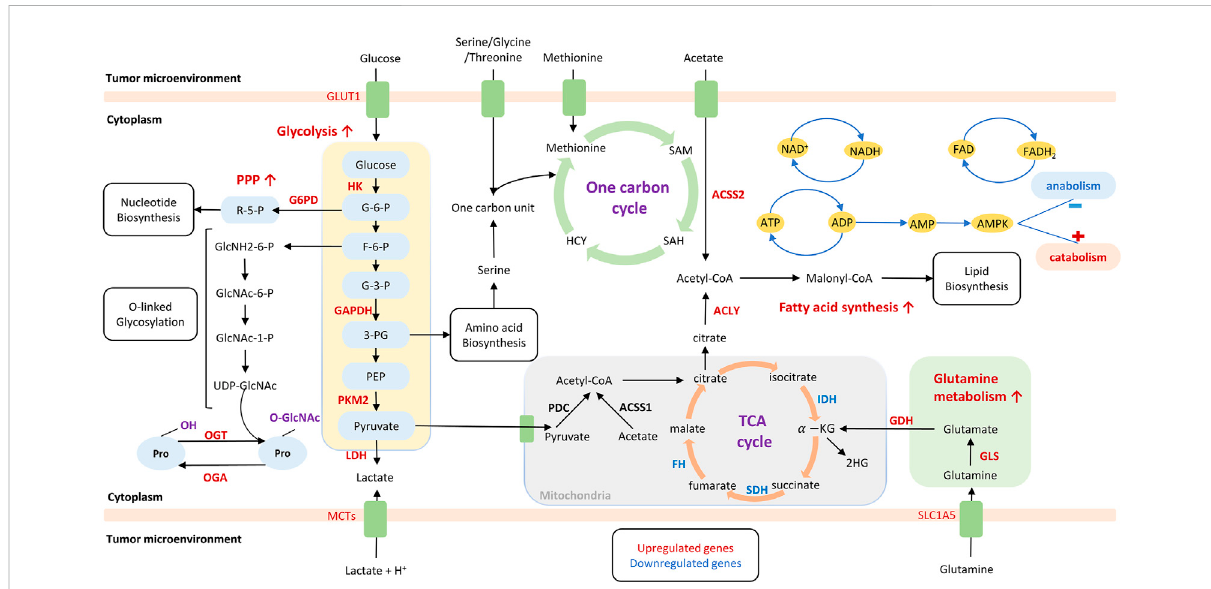
FIGURE 1 Metabolism reprogramming in cancer cells. Metabolism reprogramming is characterized by a class of altered pathway, including enhanced glycolysis with increased lactate production, and enhanced pentose phosphate pathway, fatty acid synthesis, and glutamine metabolism. These metabolic pathways support energy supply and macromolecule biosynthesis, such as nucleotides, amino acids, and lipids. Metabolites that are produced by altered metabolism have the potential to control signaling or epigenetic pathways by regulating reactive oxygen species, acetylation, and methylation. Upregulated genes or proteins are labels red, whereas downregulated genes or proteins are labeled blue. GLUT, glucose transporter;MCT,monocarboxylatetransporter;SLC1A5,solutecarrierfamily1member5;TCA,Tricarboxylic acidcycle;G6PD, glucose-6- phosphate dehydrogenase; HK, hexokinase; GAPDH, glyceraldehyde-3-phosphate dehydrogenase; PKM, pyruvate kinase M 2; LDH, lactate dehydrogenase;ACSS2,Acyl-CoA short-chainsynthetase-2; ACSS1:Acyl-CoA short-chainsynthetase-1; ACLY:ATP citratelyase; GLS,glutaminase; GDH, glutamate dehydrogenase; PDC: pyruvate dehydrogenase complex; FH, fumarate hydratase; SDH, succinate dehydrogenase; IDH1/2, isocitrate dehydrogenase 1/2; HCY, homocysteine; PPP, pentose phosphate pathway; ATP, adenosine triphosphate; ADP, adenosine diphosphate; AMP, adenosine monophosphate; AMPK, AMP-activated protein kinase; OGT, O-GlcNAc transferase; OGA,